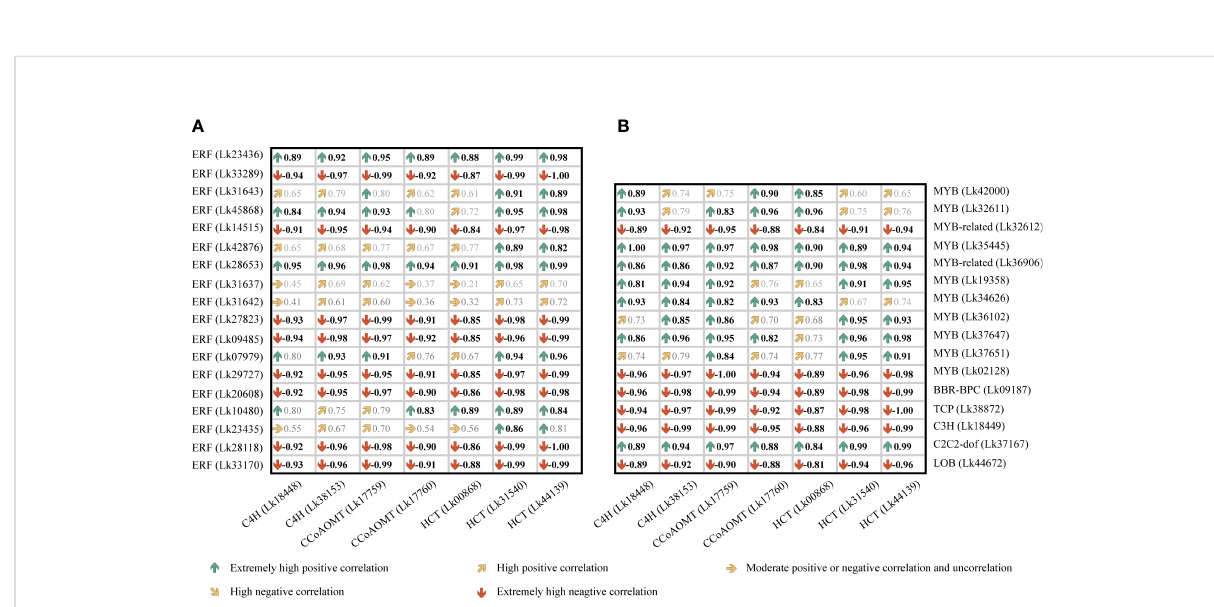
FIGURE 10 Correlation analysis of the expression levels between candidate TF genes and key structural genes involved in phenylpropanoid and fl avonoid biosynthesis in L. kaempferi callus. (A) Correlation relationship between ERF genes and key structural genes. (B) Correlation relationship between other TF genes and key structural genes. Bold black indicates signi fi cant correlation at P <